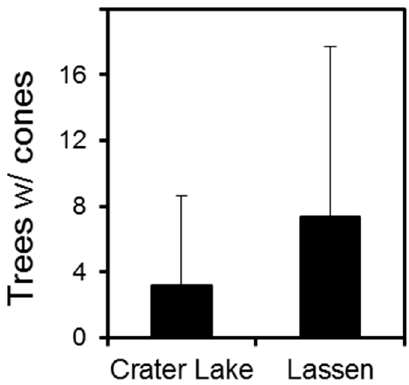
Figure 6. Number of whitebark pine trees with cones from 30 whitebark pine plots in Crater Lake and Lassen Volcanic National Parks. Means and SD are shown.